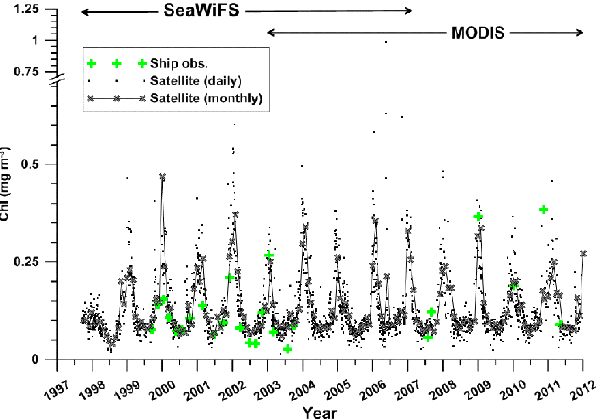
Fig. 5. The merged time-series of daily sea surface chlorophyll a data (dots) compared to shipboard observations (green crosses). Also plotted are the merged monthly data (grey